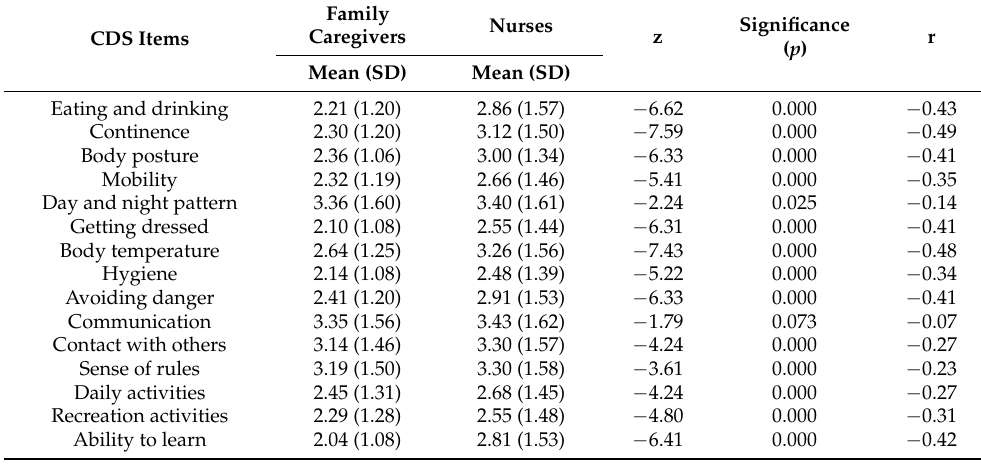
Table 3. Differences among care dependency items between